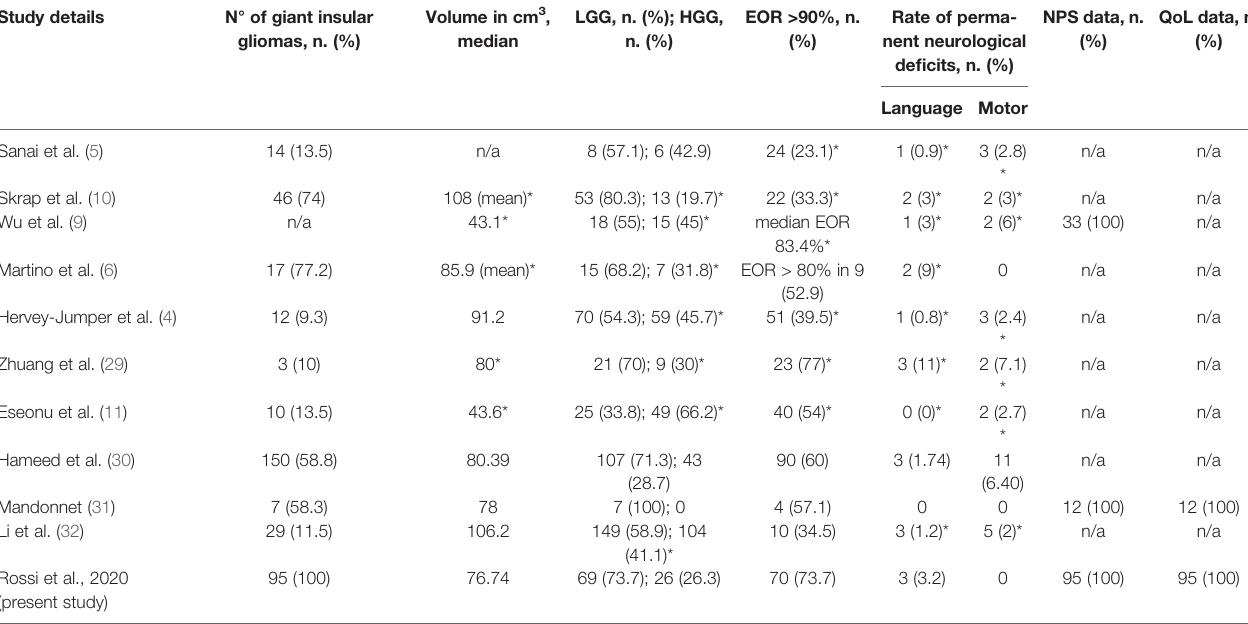
TABLE 5 | Clinical studies on giant insular gliomas